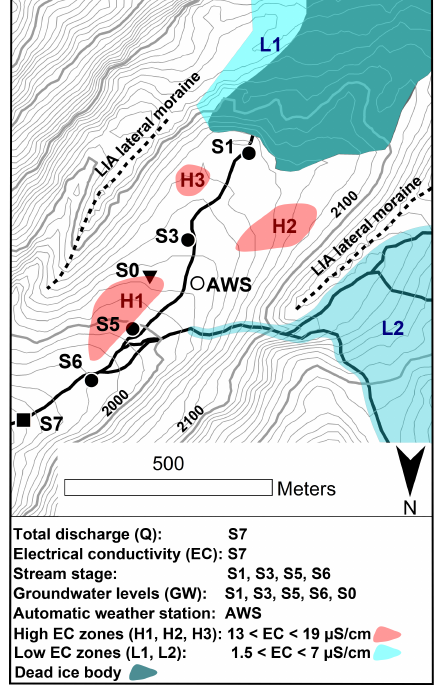
Figure 1. The Damma Glacier forefield. At sites S1, S3, S5 and S6 (solid circles), stream and groundwater levels are recorded. At site S7 (solid square), stream stage is measured for total discharge. At site S8 (solid triangle), only one piezometer is installed. Colour patches indicate zones of high (H1, H2 and H3) and low (L1, L2) electrical conductivity. An automatic weather station (AWS) is lo- cated in the middle of the forefield. Lateral moraines are indicated with dashed black lines and terrain elevation is shown by 10m con- tour intervals (figure adapted from Magnusson et al.,